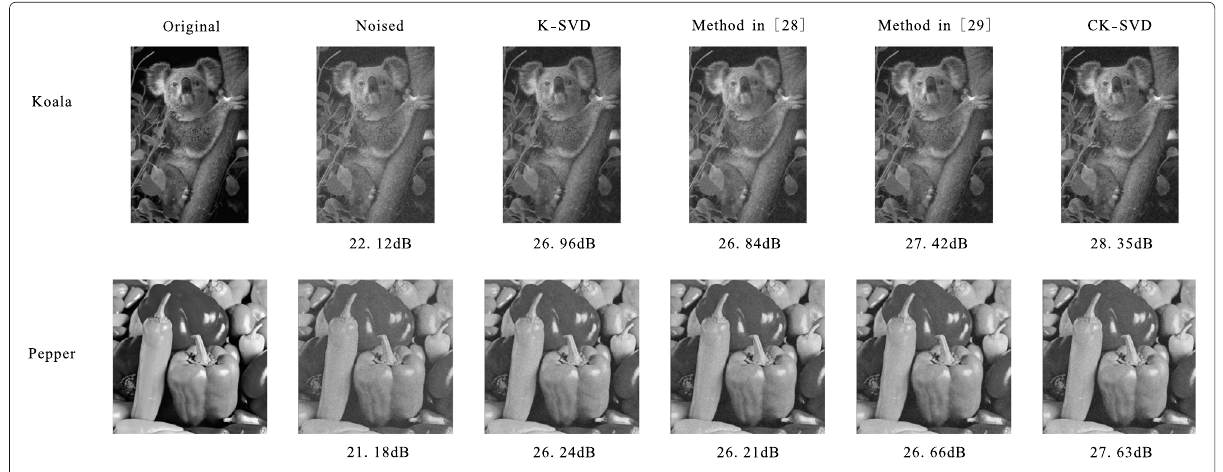
Fig. 11 Denoising results with the noise level of σ =